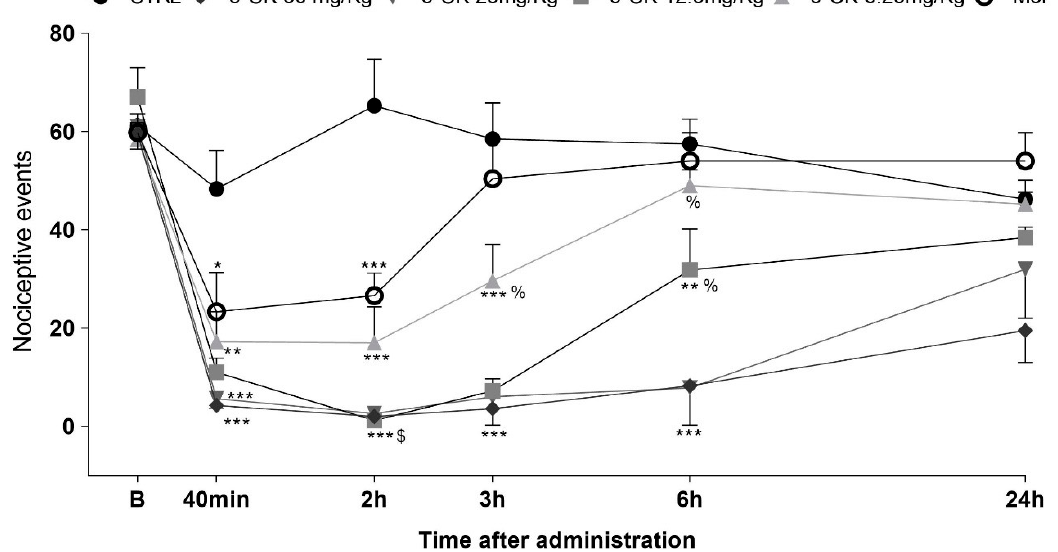
Figure 3. Antinociceptive effect of 5-CK on the cold plate test. Mice were treated by intraperitoneal route 40 min before the test. For the dose − response analysis, the effects of increasing doses (6.25 to 50 mg/Kg) were tested. To evaluate the time-course of the antinociceptive effect, the thermal nociceptive threshold was measured before (B) and up to 24 h following administration of 5-CK, vehicle (CRTL, 50% propylene glycol in saline; control group) or morphine (Mor; 5 mg/Kg), the reference drug. Data are expressed as mean times ± SEM; n = 6 mice per group. $ Significantly different from morphine group ( p < 0.001). % Significantly different from 5-CK 50mg/Kg group ( p < 0.05). * Significantly different from the control group ( p < 0.05). ** Significantly different from the control group ( p < 0.01). *** Significantly different from the control group ( p < 0.001). Two-way ANOVA followed by Bonferroni’s